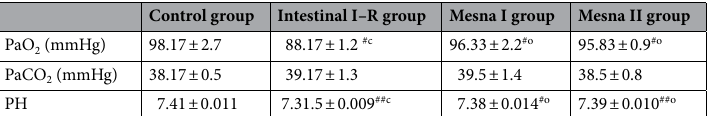
Table 1. Measurements of arterial blood gases and pH. Values are expressed as mean ± standard error (X ± SE). PaO 2 , partial pressure of O 2 ; PaCO 2 , partial pressure of CO 2 . # Significant difference ( P < 0.05). ## highly significant difference (P < 0.001); n = 6 animals. c P compared to control group. o P compared to intestinal I–R group.